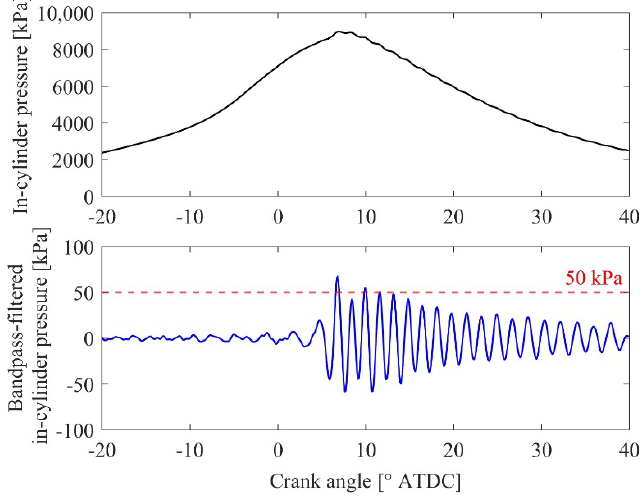
Figure 1. Knock detection procedure. ( Top ): Measured in-cylinder pressure history. ( Bottom ): Knock intensity is the maximum value of the one-sided amplitude of in-cylinder pressure after the bandpass filter is applied. The cycle in which the value exceeded 50 kPa was defined as the knock cycle.